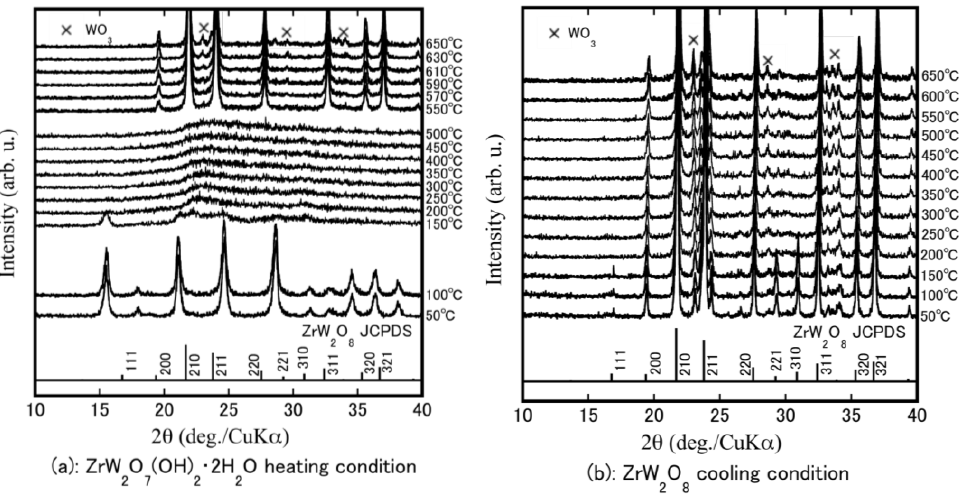
Figure 2. High temperature (HT)-XRD patterns of Zr – W – O system precursor at a temperature program of heating from 50 °C to 650 °C ( a ); and then cooling from 650 °C to 50 °C ( b ).